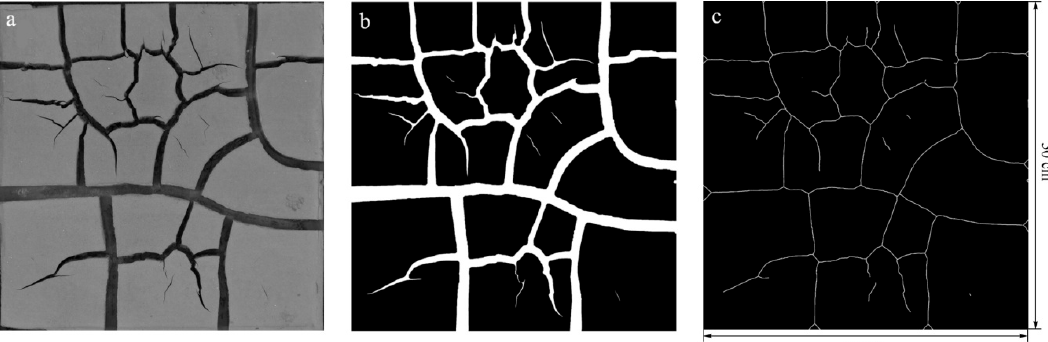
Figure 2. The digital image processing of crack patterns.